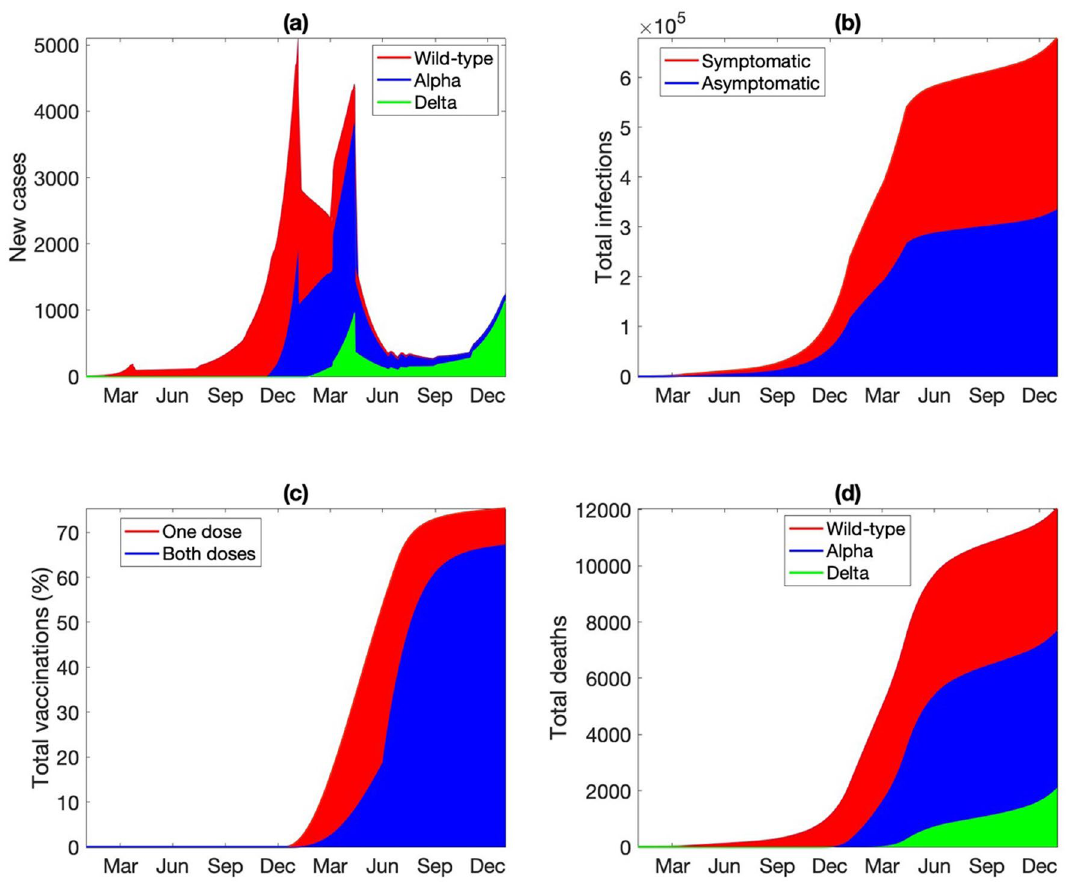
Figure 2. ( a ) Number of new infections for each of the viruses, shown as 7-day means from January 1 2020 to December 31 2021. ( b ) Cumulative asymptomatic and symptomatic infections for all viruses. ( c ) Fraction of population vaccinated with at least one dose and with both doses. ( d ) Cumulative deaths from each of the